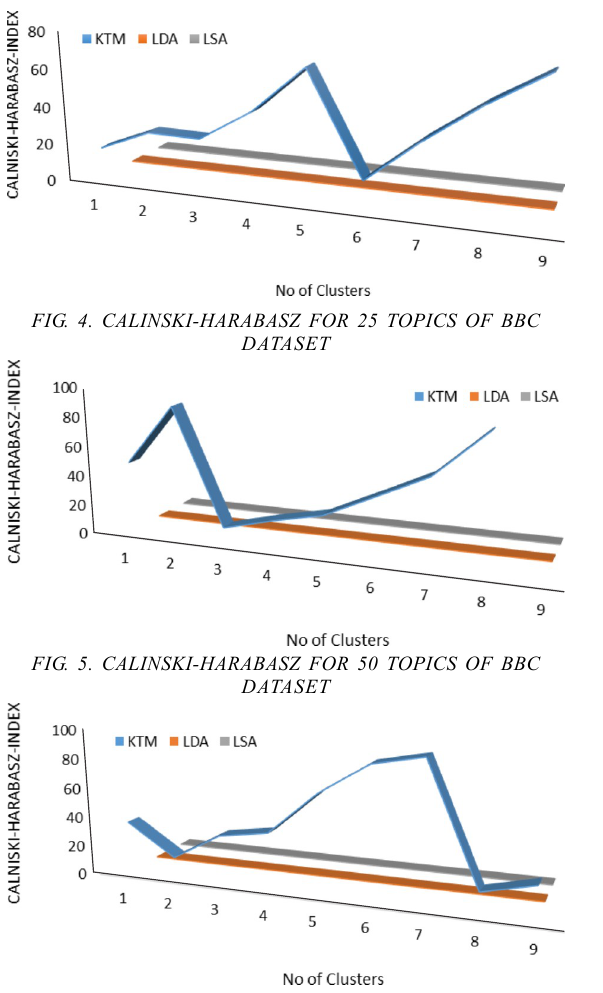
FIG. 6. CALINSKI-HARABASZ FOR 75 TOPICS OF BBC DATASET